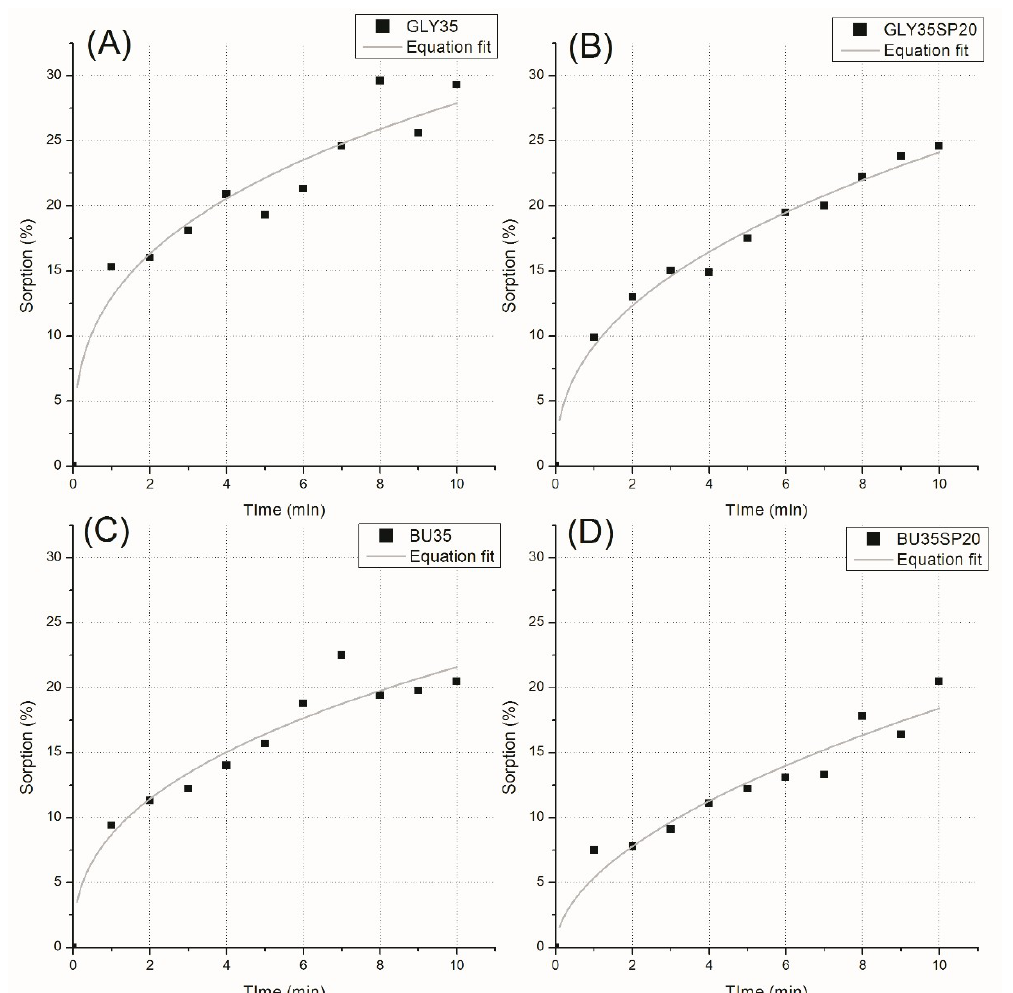
Figure 5. Kinetic water absorption test results with a sample of gluten plasticized with 35% of glycerol ( A ) and with the addition of 20 php of microalgal biomass ( B ); with 35% of 1,4-butanediol ( C ) and with the addition of 20 php of microalgal biomass ( D ).